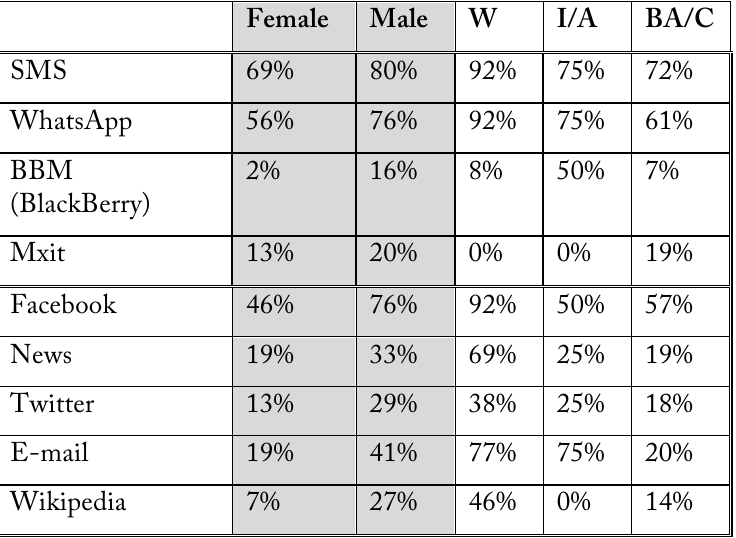
Table 4: Use of messaging service and other services